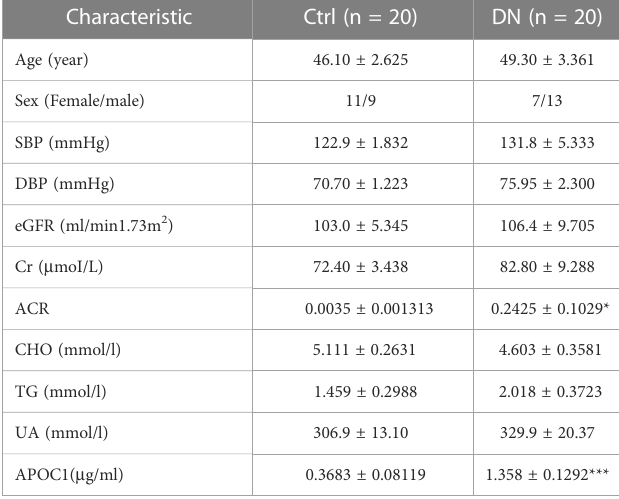
TABLE 1 Baseline